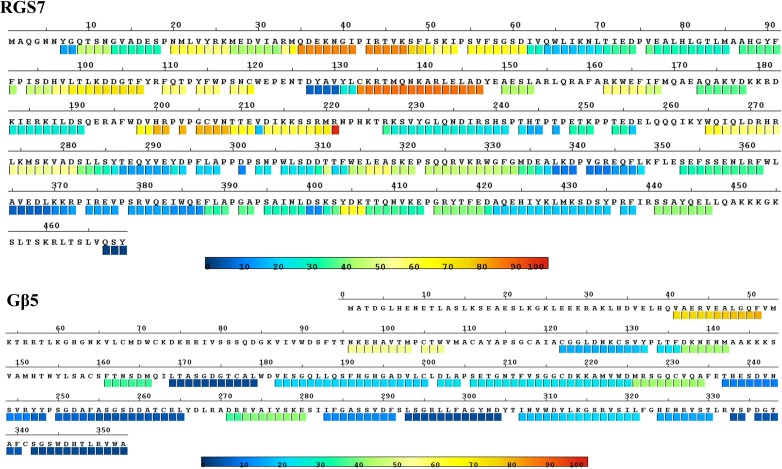
Baseline HDX mapping of RGS7 and Gβ5.Intrinsic HDX behavior mapped on the sequence of RGS7 and Gβ5. Percentage of deuterium exchange of peptides from dimeric RGS7/Gβ5 complex. The color coding same as in Figure 5b, HDX rates are higher (red) reflecting greater flexibility and lower (blue) reflecting slower conformational dynamics. Raw HDX data are deposited at: https://doi.org/10.6084/m9.figshare.7316462.v2.